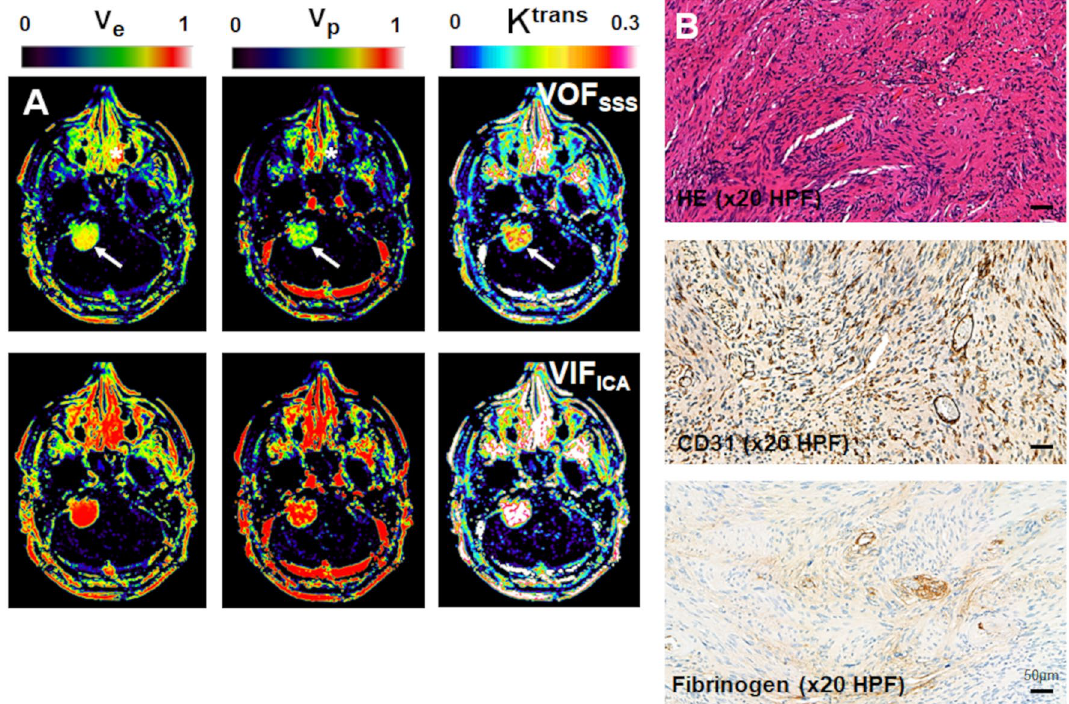
Figure 6. Parameter maps and tissue sections from a large sporadic VS demonstrates overestimation of kinetic parameters (v e , v p , K trans ) with use of VIF ICA . ( A ): Representative LEGATOS derived kinetic parameter maps from a patient with a large right sided sporadic VS. From left to right: parametric v e map; parametric v p map and parametric K trans map. Note the comparatively higher v e v p and K trans estimates within the tumour ( arrow ) and nasal mucosa ( * ) when using the ICA derived vascular input function (VIF ICA ). ( B ): Representative tissue sections from the tumour shown in panel A. From top: Haematoxylin and eosin-stained section (HE-x20HPF); CD31 immunostain for microvessels (brown; immunoperoxidase –x20HPF); fibrinogen immunostain for perivascular leak (brown; immunoperoxidase –x20HPF). In keeping with the VOF SSS kinetic parameter estimates, the tumour is moderately cellular (mean tumour v i ~ 0.35) with some regions of moderate/high microvessel density (CD31) and perivascular leak (fibrinogen). The VIF ICA and VIF MCA kinetic parameter estimates, however, overestimate both the size of the tumour extravascular-extracellular space (v e ) and the degree of tumour vascularity (v p